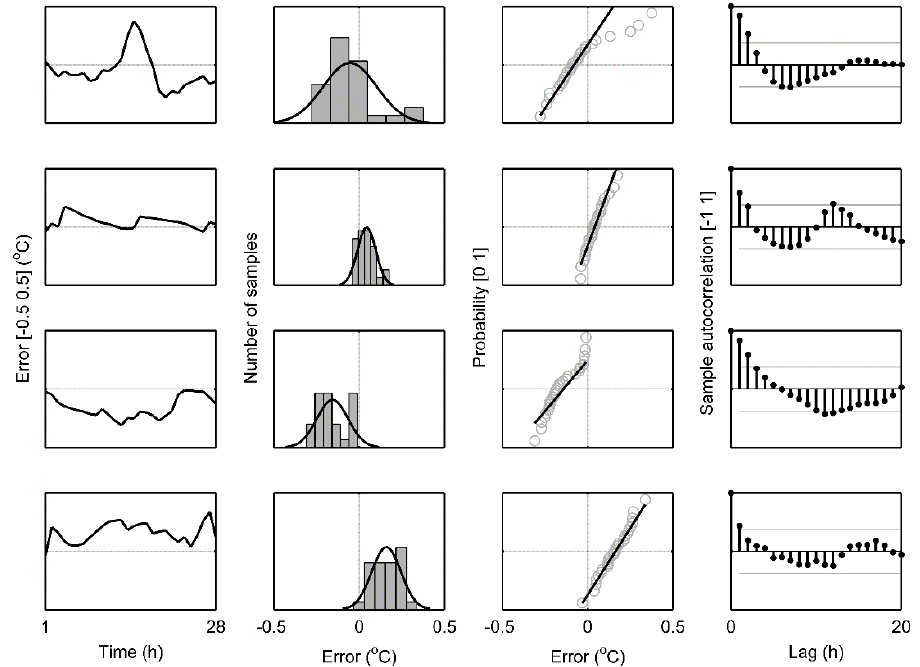
Figure 6. Analysis of the modelling error in case of model structure P1P3 with data from building A for four validation runs. Validation data set 1, 2, 3 and 4 are presented from the up to bottom row respectively. From left to right column: Modelling error (model output–measured); Histogram of the modelling error (grey bars) with normal distribution fit (black line); Normal probability plot for modelling errors; the sample autocorrelation function of the modelling error with 95% confidence bounds (grey lines).